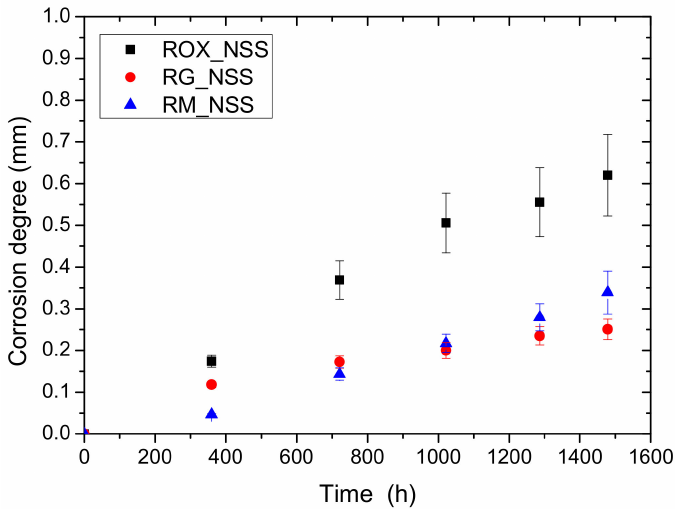
Figure 10. Evolution of the corrosion degree for X-cut panels submitted to cyclic NSS.